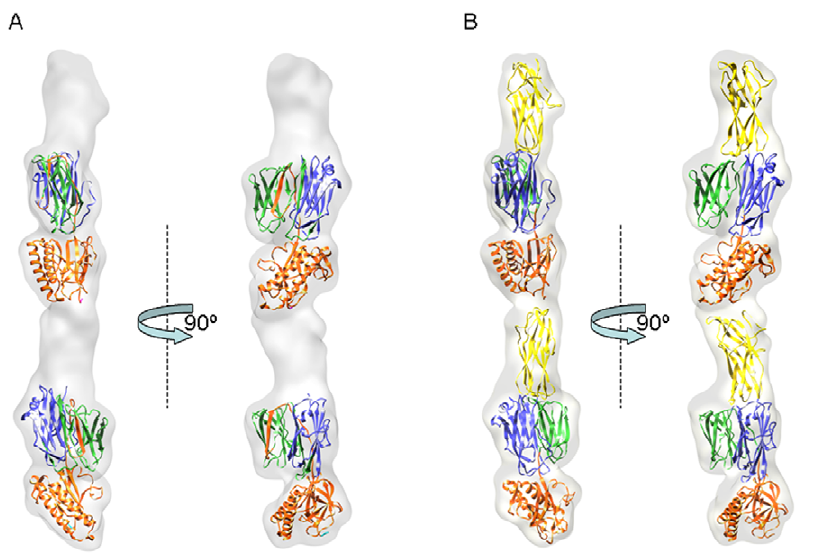
Figure 6. Fitting of the RrgBD2–D4 crystal structure and of the RrgBD1 computer model into the 3D map of the S.pneumoniae pilus. A) Semi transparent rendered surface representations of the 3-D map of the S. pneumoniae pilus viewed along the z-axis tilted by 90 u showing the docking of two copies of the atomic resolution RrgBD2–D4 subunit into the pilus reconstruction. Empty densities present above the two fitted RrgBD2–D4 copies have a volume of , 21 6 e 3 A˚ 3 each. B) Same semi-transparent rendered surface representations as in panel A showing the docking into the pilus reconstruction of two copies of the RrgBD2–D4 subunit and contemporaneously of two computer model RrgBD1 domains. The docking reveals that the inter-subunit density (7 A˚ thick) present between the upper and lower subunits could accommodate the 8-residue C- terminal tail, not present in the RrgBD2–D4 crystal. Crystal structures are in cartoon representation and the three domains are coloured following the nomenclature of Figure 3. Figure produced with Pymol (http://www.pymol.org/). Surface representation and molecule rendered with Chimera [29].